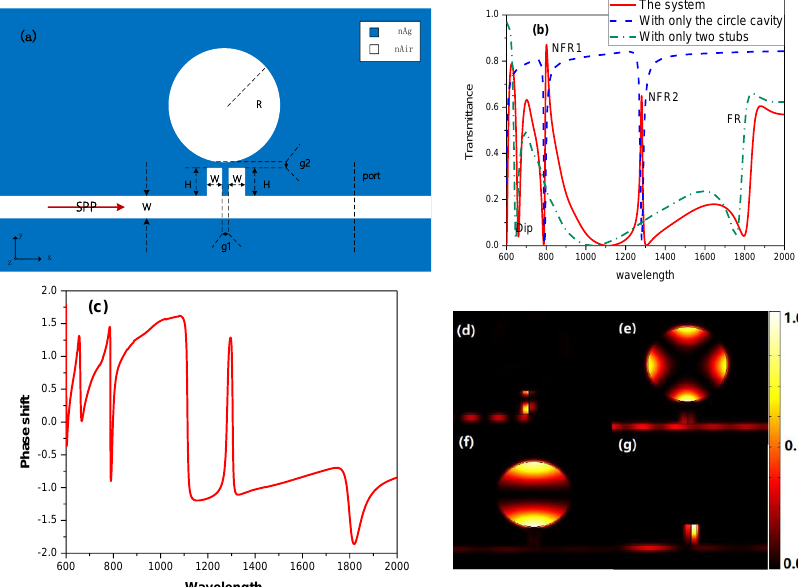
Figure 2. ( a ) The schematic diagram of the structure added a circular cavity on the two stubs. ( b ) The transmittance spectra of the extend model with H = 200 nm, g1 = g2 = 10 nm and R = 340 nm (the red solid line), the MIM waveguide with a circle cavity (the blue dash line) and the MIM waveguide with two stubs (the green dash-dot line). ( c ) The phase shift spectrum of the extended structure. ( d–g ) The normalized field intensity distribution ( |𝐻 𝑍 | 2 ) at λ = 661 nm (d), λ = 802 nm (e), λ = 1281 nm (f), and λ = 1880 nm (g).